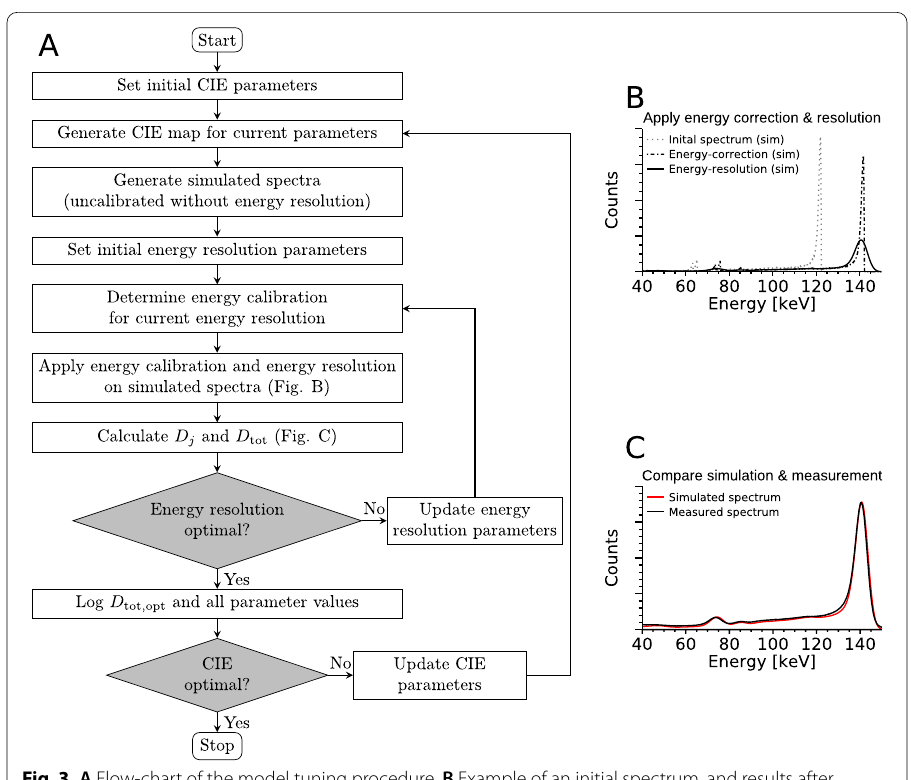
Fig. 3 A Flow-chart of the model tuning procedure. B Example of an initial spectrum, and results after applying the energy correction and energy resolution. C Comparison against measured